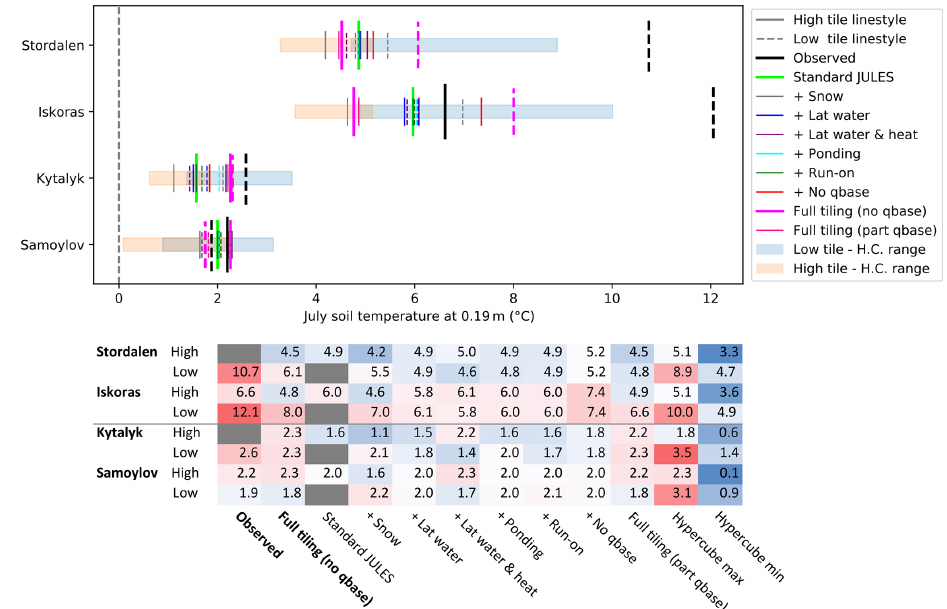
Figure B2. July soil temperature (2000–2016) at 0.19m for the additive process-switching runs, where model processes are switched on one at a time starting from the base configuration of standard JULES (light green). The depths of the observations are as follows: for Samoylov, the rim was at 0.21m, and the centre was at 0.2m; for Kytalyk the rim was at 0.15m, and the centre was at 0.25m; for Iškoras, the palsa and mire were at 0.2m; and for Stordalen the mire was at